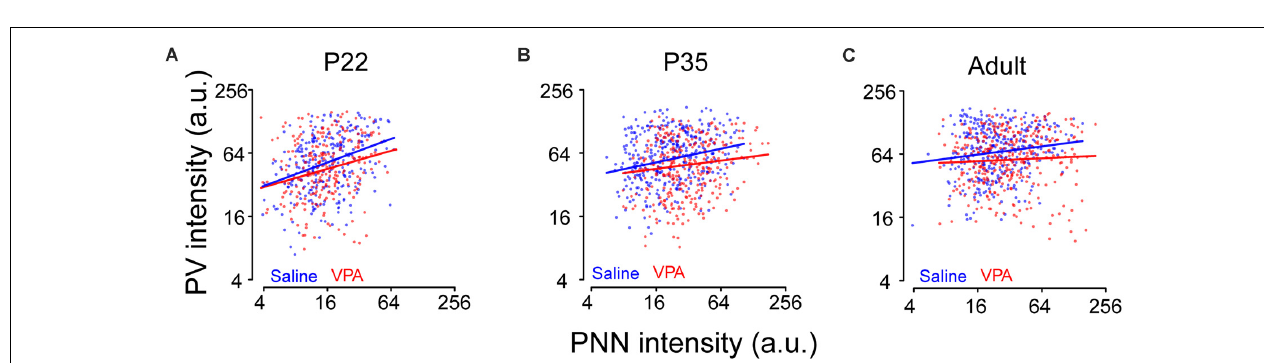
FIGURE 3 | Relationship between PV and PNN intensities for a given neuron at different ages in saline and VPA mice. Logarithmic scales were used to present the values of PV and PNN intensities. Lines represent the relationship between the logarithm transformations of PV intensity [log(PV)] and PNN intensity [log(PNN)]: log(PV) = a × log(PNN) + b. (A) At P22, a = 0.37, b = 2.92 in saline group; a = 0.29, b = 3.02 in VPA group. (B) At P35, a = 0.22, b = 3.36 in saline group; a = 0.13, b = 3.45 in VPA group. (C) In adult, a = 0.13, b = 3.78 in saline group; a = 0.05, b = 3.88 in VPA group. Linear mixed models were applied to explore the correlation between log(PV) and log(PNN) using cells as the statistical units. N = 287, 366, and 351 cells in P22, P35, and adult saline groups, respectively. N = 242, 305, and 348 cells in P22, P35, and adult VPA groups, respectively.